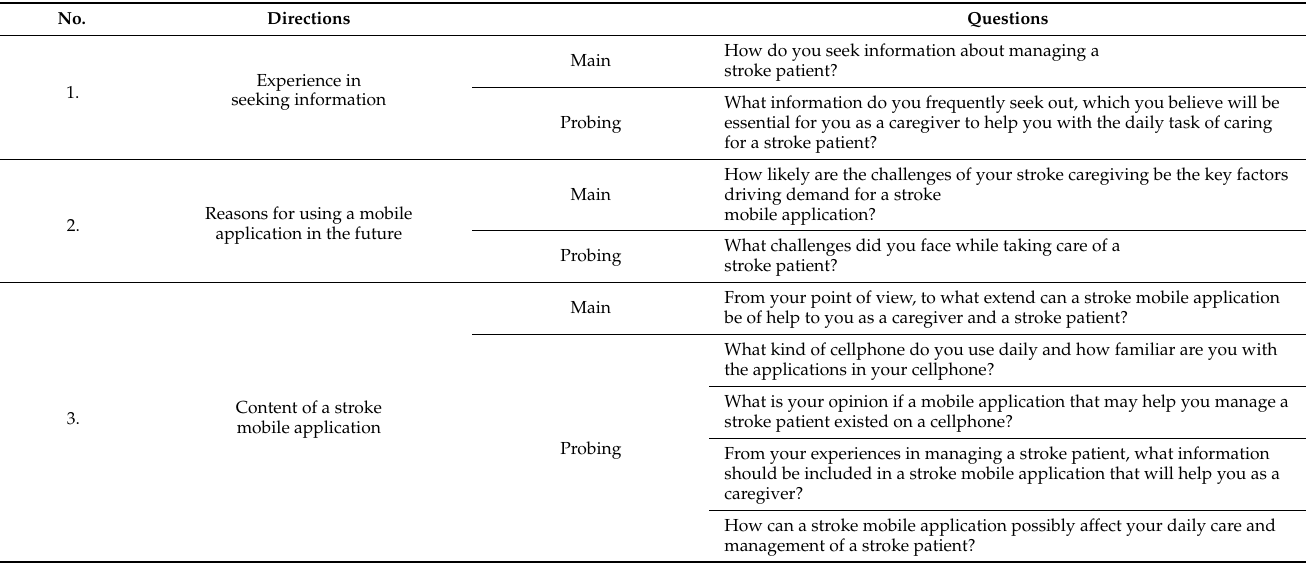
Table A1. Examples of main and probing questions.